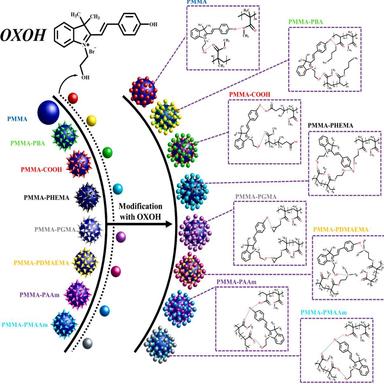
The proposed schematical mechanism for the stability and solvatochromism of the OXOH molecule by hydrogen bonding interactions with functional groups of the polymer nanoparticles.